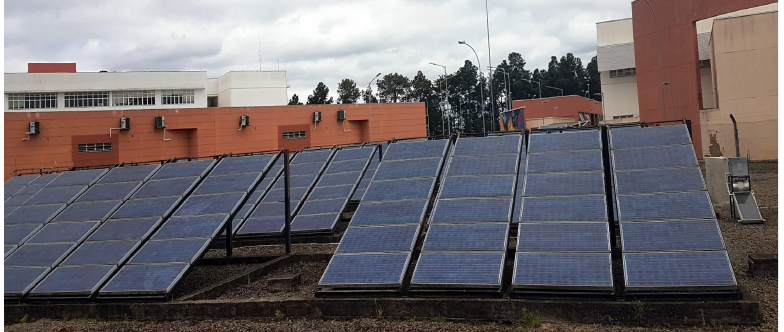
Figure 16. Photo-voltaic power plant of the solar laboratory at Federal University of Juiz de Fora (UFJF), Brazil.